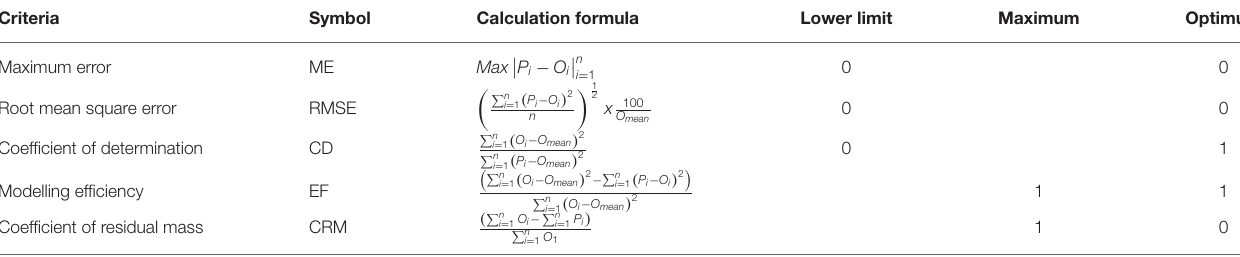
TABLE 3 | Statistical criteria for model performance evaluation proposed by Loague and Green (1991) used for model performance evaluation. Criteria Symbol Calculation formula Lower limit Maximum Optimum